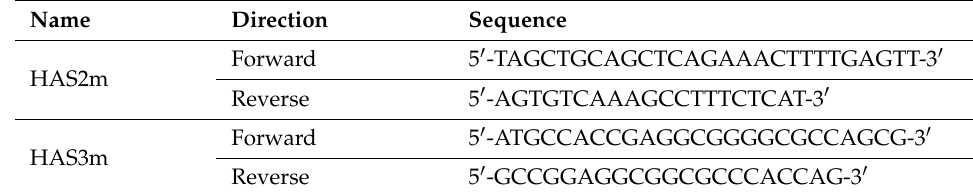
Table 1. Primer pairs for mutation.